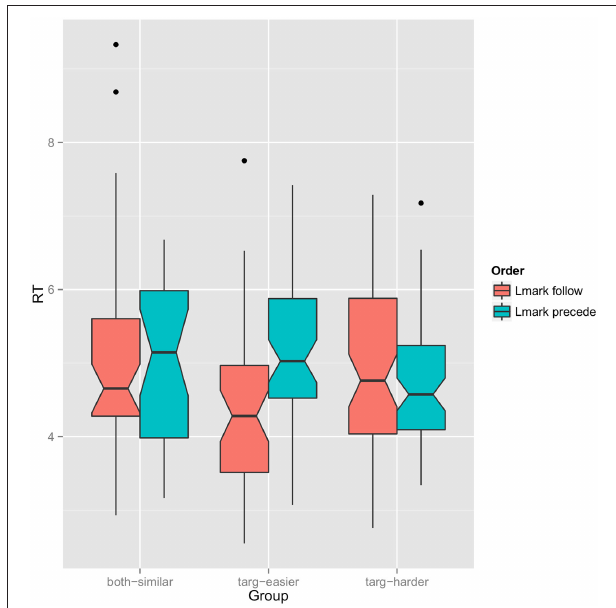
FIGURE 3 | Notched boxplot of reaction time as a function of referring expression order (red: target first, blue: landmark first) grouped by which object is easier to find. Notches represent 95% confidence interval of the median (computed with GGPlot default settings).